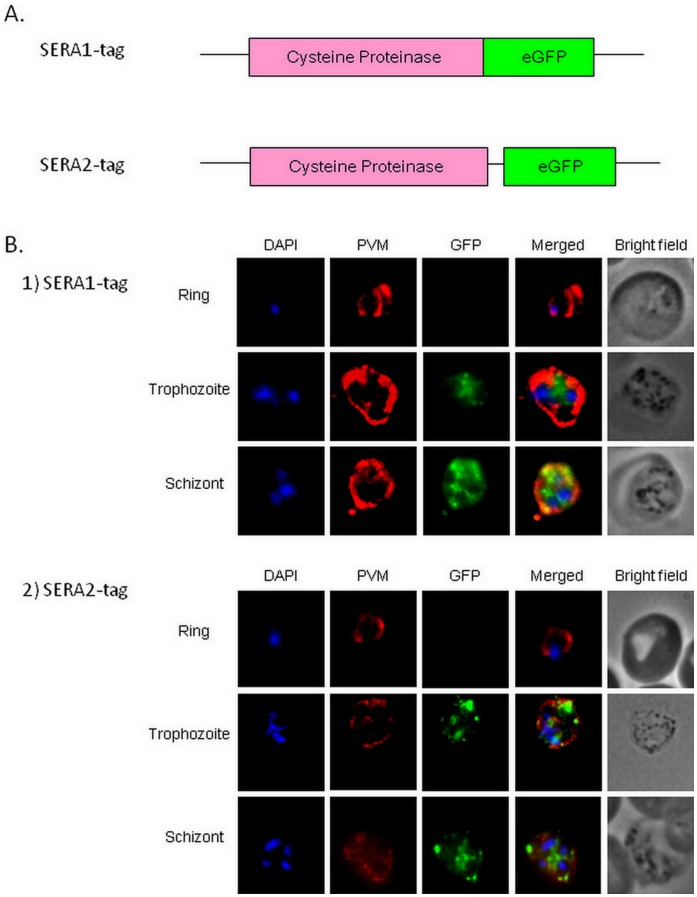
Localization of eGFP-tagged SERA1 and SERA2.A. Schematic representation of constructs of eGFP-tagged SERA1 and SERA2; B. Immunofluorescent assays of parasites with eGFP-tag stably integrated in either SERA1 (upper panel) or SERA2 (lower panel).